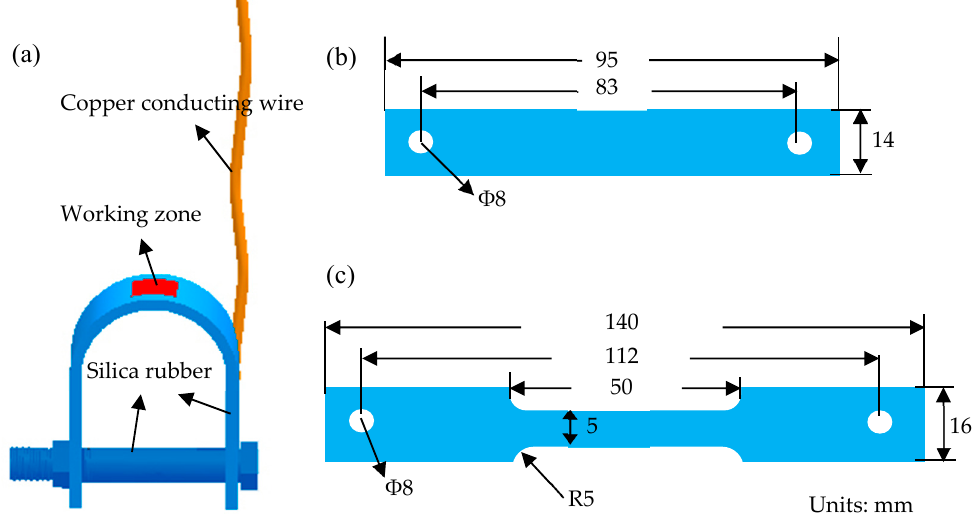
Figure 2. ( a ) Schematic of the U-bend samples for electrochemical measurements and immersion tests; ( b ) and ( c ) are the geometry of the U-bend and SSRT samples, respectively. The thicknesses of the U-bend and slow strain rate tensile (SSRT) samples are 2